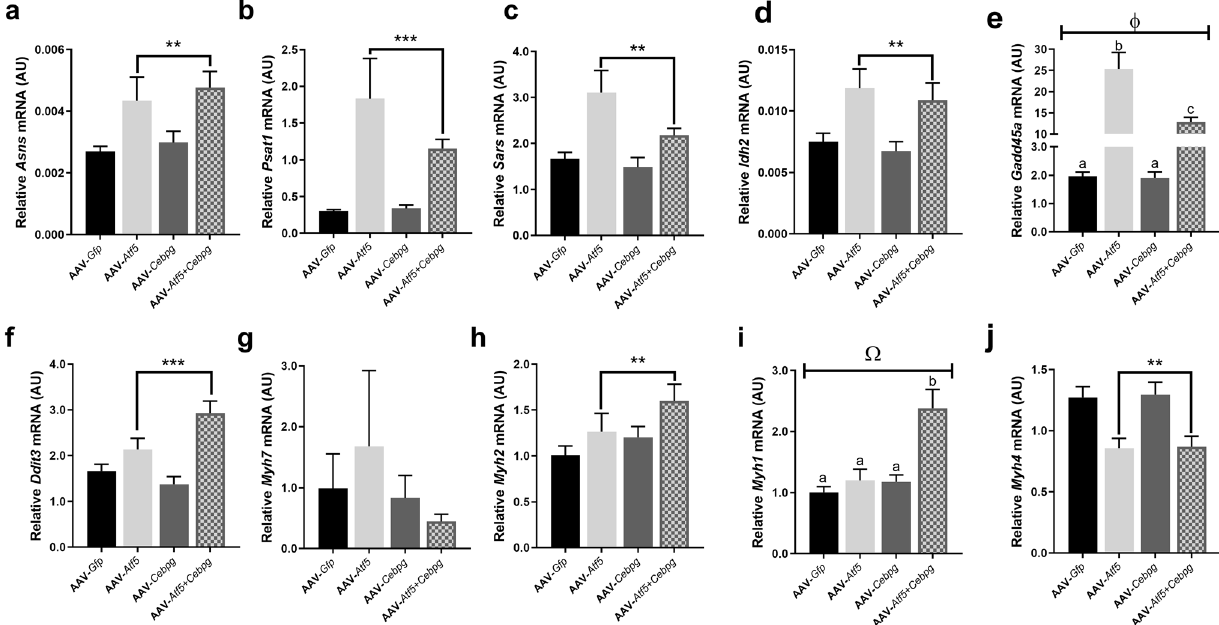
Figure 9. Effect of AAV-mediated overexpression of Atf5 and Cebpg individually and in combination (AAV- Atf5 ± Cebpg ) on endogenous mRNA expression. Relative mRNA expression for ( a ) Asparagine synthetase ( Asns ), ( b ) Phosphoserine Aminotransferase-1 ( Psat1 ), ( c ) Seryl-tRNA Synthetase ( Sars ), ( d ) Isocitrate dehydrogenase-2 ( Idh2 ), ( e ) Growth Arrest and DNA-Damage-Inducible 45 Alpha ( Gadd45a , also known as Ddit1 ), ( f ) DNA Damage Inducible Transcript 3 ( Ddit3 , also known as CHOP ), and ( g – j ) Myosin heavy chain (MyHC) isoforms were determined in the Extensor Digitorum Longus (EDL) muscle following 28 days AAV-mediated overexpression. ( g ) Myh7 encodes slow oxidative MyHC-I, ( h ) Myh2 encodes fast oxidative MyHC-IIA, ( i ) Myh1 encodes fast oxidative-glycolytic MyHC-IIX and ( j ) Myh4 encodes fast glycolytic MyHC- IIB. All mRNA expression data was normalised to OliGreen, as a measure of total cDNA. Data presented as Means (n = 8, except n = 24 for AAV- Gfp ) ± SEM. φ indicates a significant AAV- Atf5 × AAV- Cebpg interaction ( P = 0.005), and Ω indicates a trend for an interaction ( P = 0.06); different letters indicate statistical significance ( P < 0.05). ** P < 0.01, *** P < 0.001 indicates significant effect of AAV- Atf5 overexpression might induce hypertrophy, overexpression of the individual downstream ISR targets had no effect (AAV- Asns , - Phgdh , - Psat1 , - Sesn2 , - Slc3a2 ) or resulted in muscle atrophy (AAV- Arg2 ) of the transduced TA muscle. Arginase has two isoforms: cytosolic ARG1 and mitochondrial ARG2, which catalyse the conversion of arginine to ornithine and urea as part of the urea cycle. ARG1 is mainly found in the liver whilst ARG2 is ubiq- uitously expressed in various tissues 10 and is highly expressed in certain prostate 11 and pancreatic cancers 12,13 , pression resulted in a significant reduction in mouse TA and EDL muscle weights. Relative mRNA expression of Asns , Psat1 , Sars , Gadd45a and Ddit3 were all significantly increased in the EDL; which might indicate the